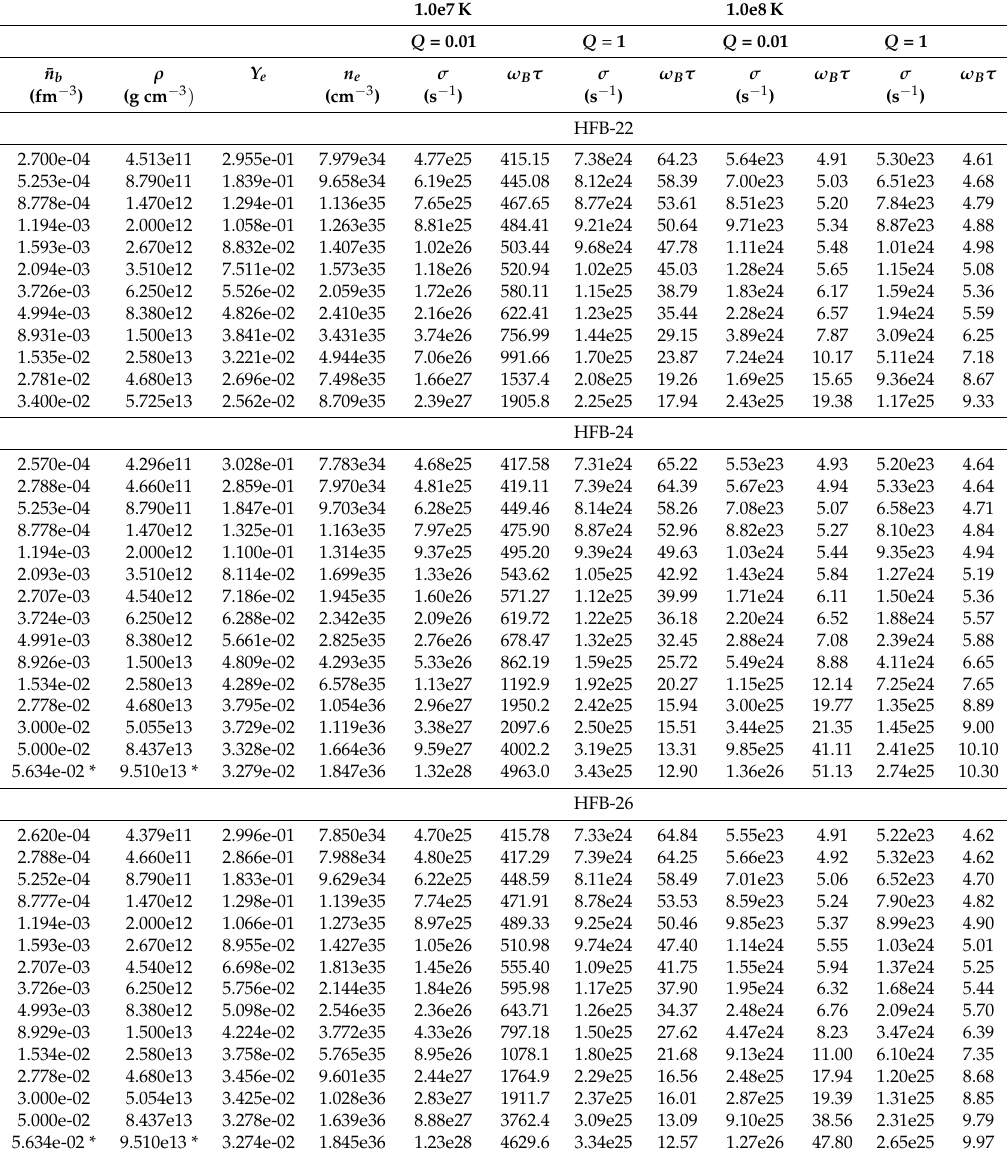
Table 3. Partial values of electrical conductivity and magnetization parameter for two different temperatures T and two different impurity parameters Q in the inner crust of NSs for the nuclear mass models HFB-22, HFB-24 and HFB-26. The unit of magnetization parameter ω B τ is the normalized magnetic field B 0 / ( 10 13 G ) when the dipolar magnetic field strength B 0 = 1.0 × 10 13 G. Here the crust is assumed to be isothermal.